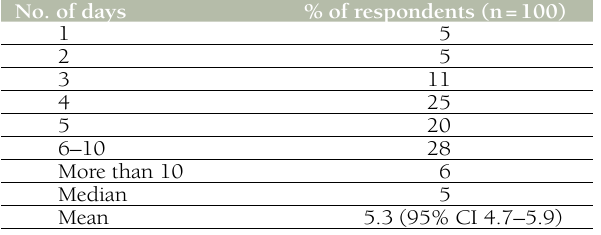
Table 2. Duration of reference diarrhea episode (zinc was